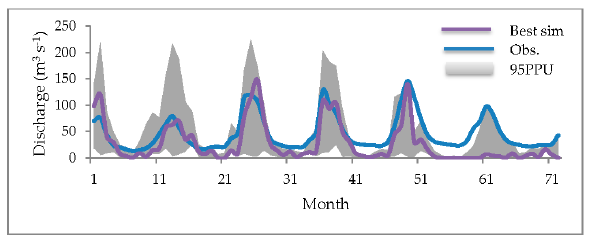
Figure 3. Illustration of model output uncertainty expressed as 95% prediction uncertainty (95PPU) as well as measured and best simulated discharge variable.